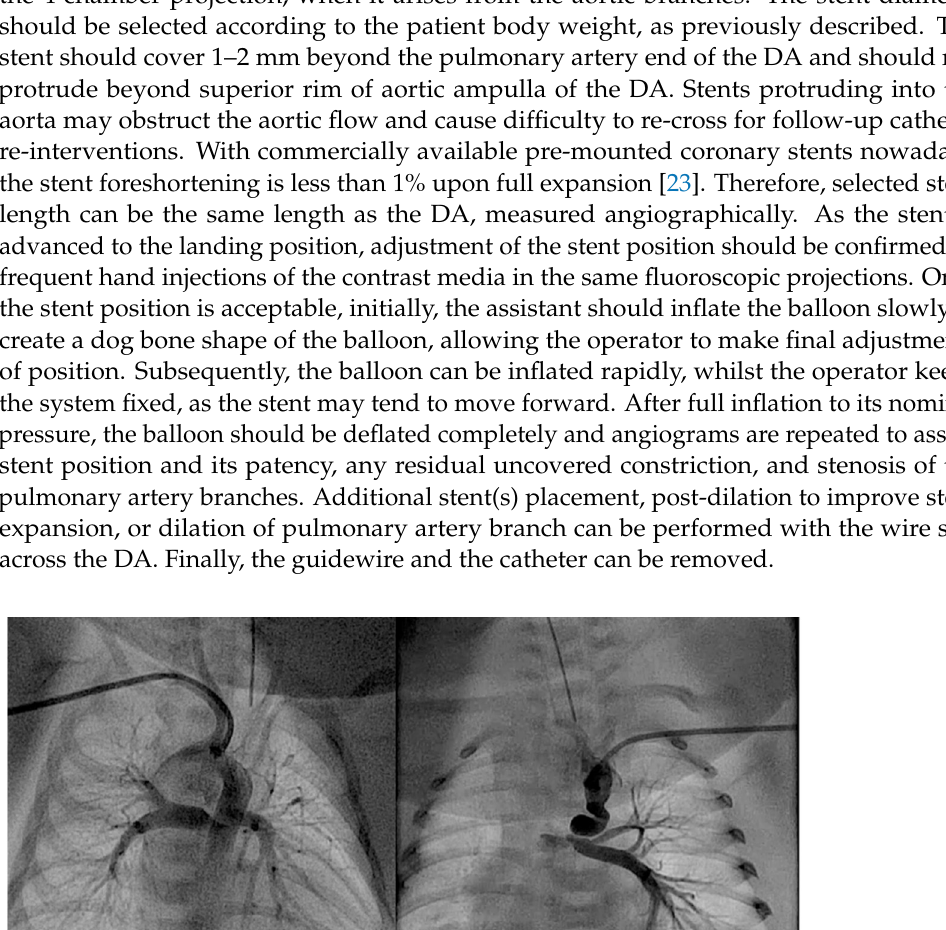
Figure 3. Lateral projection of the ductus arteriosus (DA) arising from proximal descending aorta and stenting procedure. ( A ) Selective ductal angiography demonstrated tightly constricted pulmo- nary artery end of the DA. ( B ) 0.014” coronary guidewire crossed the DA. ( C ) Stent covered entire length of the DA. MPA: Main pulmonary artery. 3.9. The Tortuous Ductus Arteriosus Increased ductal tortuosity is a predictor for procedural failure, pulmonary artery jailing, and unintended reintervention. [5,9,13,24,25] Recent publications have defined the complexity of ductal tortuosity by using the distinct equations between the total ductal length and straight length, as ductal tortuosity index (DTI) ((total ductal length/straight length-1) × 100) [17] or curvature index (CI) (total ductal length-straight length/total ductal length). [9] Until now, although there was no definite cut point to predict feasibility of